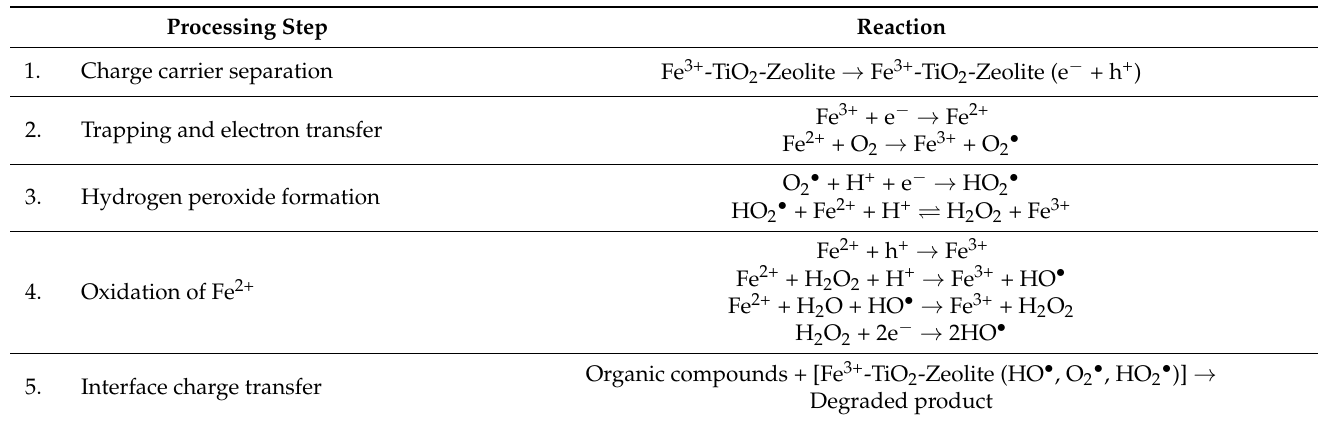
Table 5. Photodegradation reaction involving Fe 3+ -TiO 2 -Zeolite nanocomposite [88].